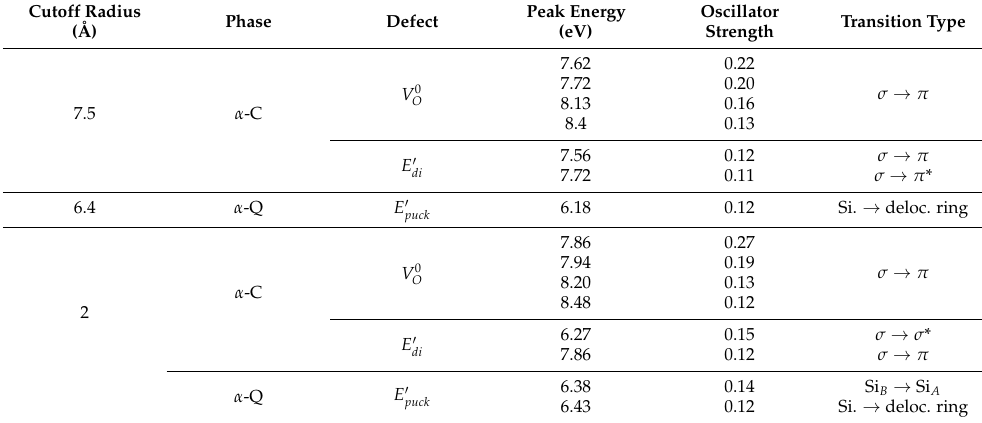
Table 3. Optical absorption of oxygen vacancies calculated using different exact exchange cutoff radii. 2 Å is the cutoff used in geometry optimization. The values 6.4 Å and 7.5 Å were the highest cutoff points for the phases of α -quartz and α -cristobalite, respectively. Transition types were determined by the state that had the largest contribution to the excitation. In the spin-polarized calculations, i.e., positively charged defects, the α spin channel contributed to a large extent to the transitions. Transition types are notated by the symmetry of the states, the Si. → Si. indicates a promotion into the singly occupied dangling bond on the same Si